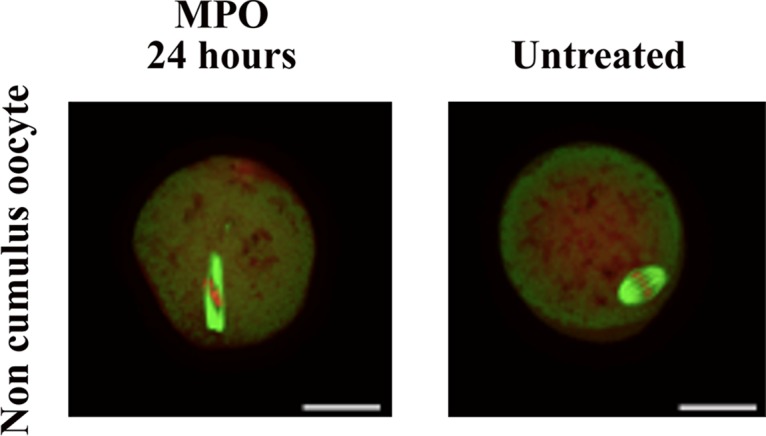
Effect of MPO on oocyte quality: The upper panel represents a noncumlus control oocyte with good quality scoring.The lower panel shows a noncumulus oocyte after incubation with MPO that received poor scoring.